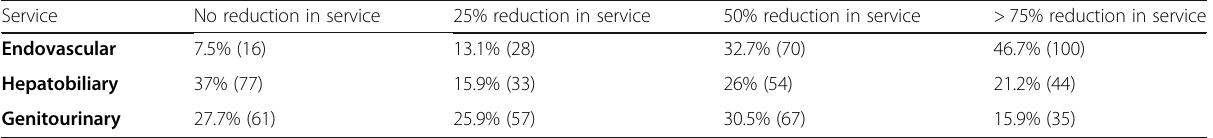
Table 1 Service provision in IR in the COVID-19 pandemic